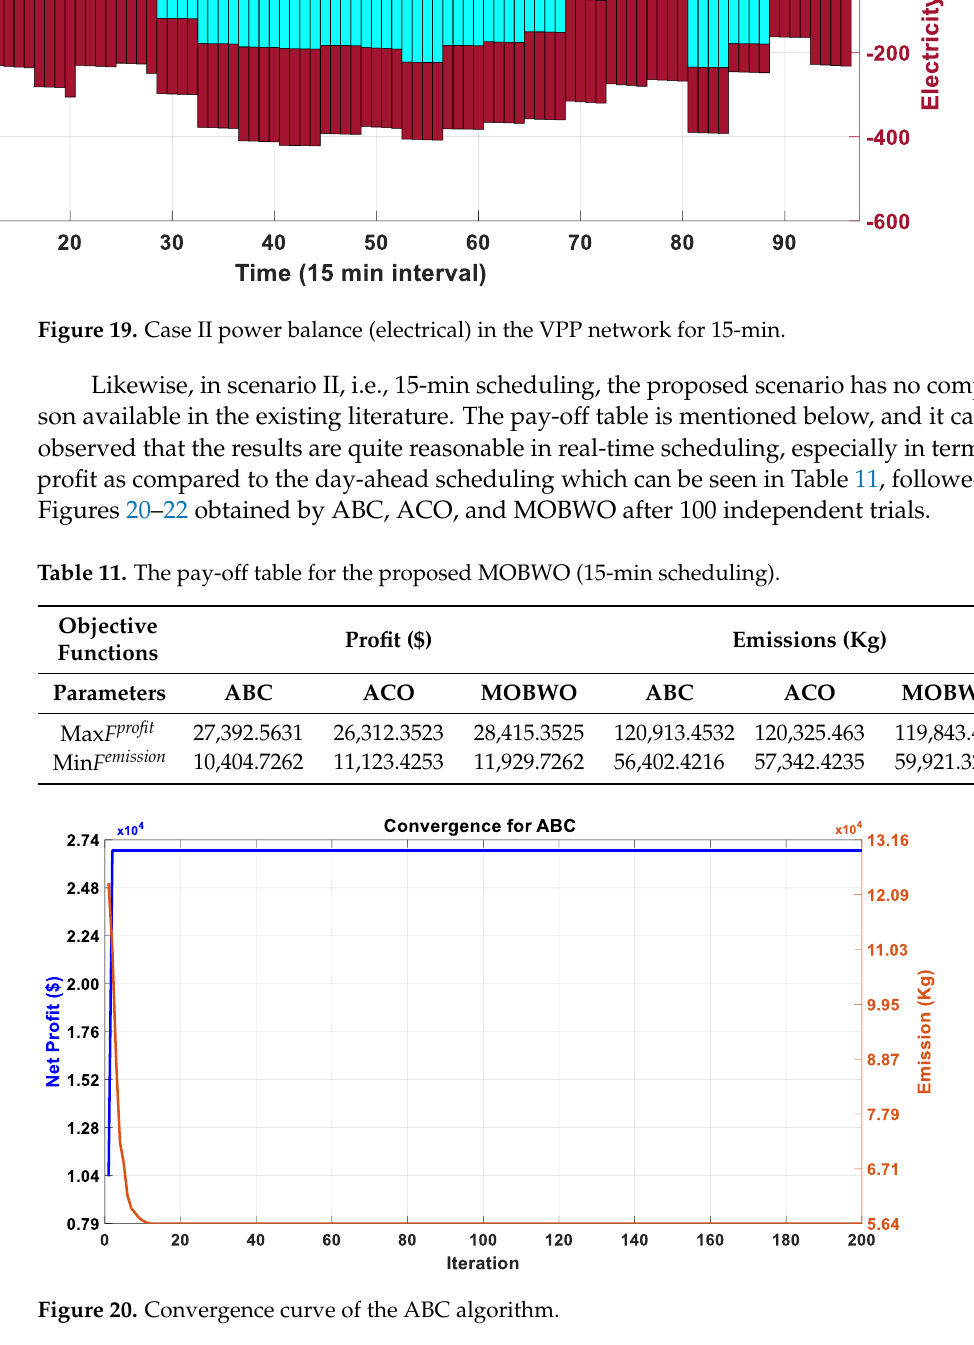
Figure 21. Convergence curve of the ACO algorithm. Figure 22. Convergence curve of the proposed MOBWO algorithm.